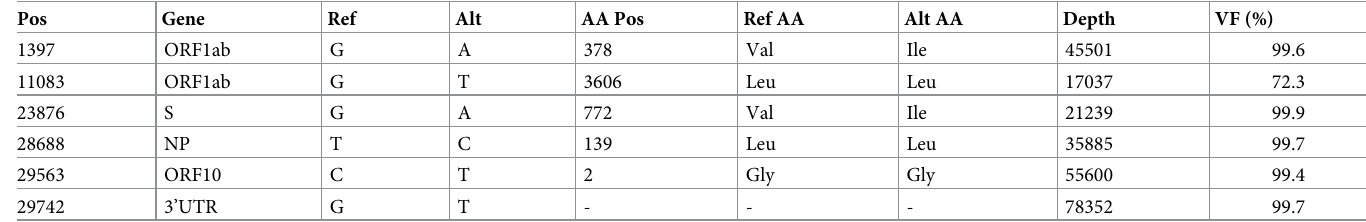
Table 1. Genetic diversity of hCoV-19/Turkey/ERAGEM-001/2020 compared to the MN908947.3 reference genome of the SARS-CoV-2 Wuhan-Hu-1